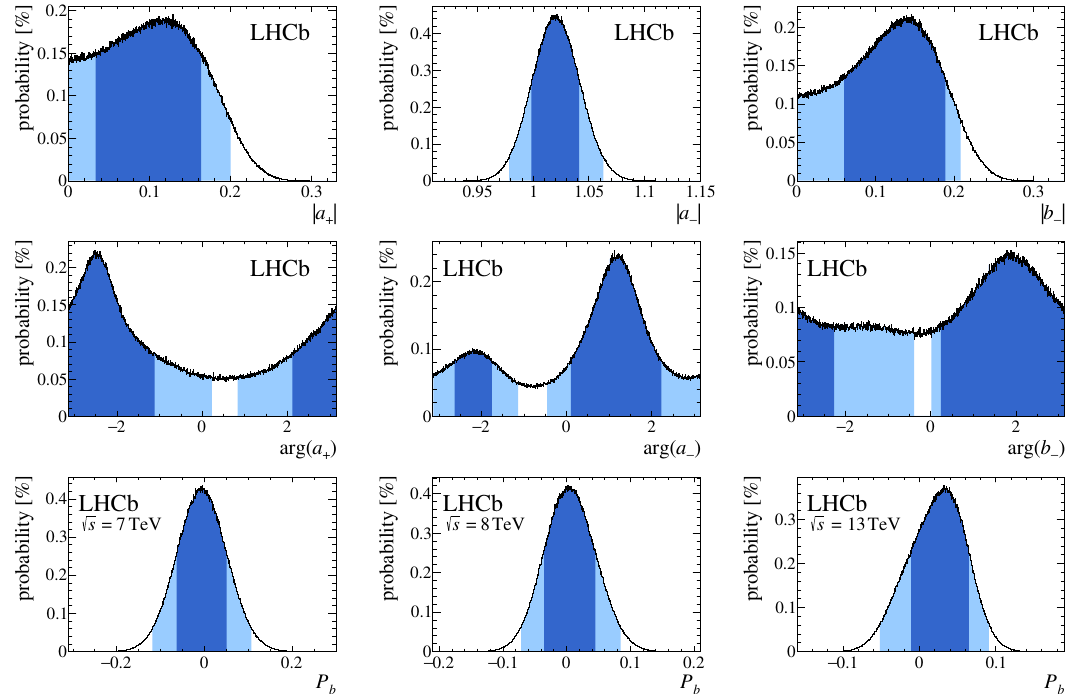
Figure 4 . Posterior probability distributions of j a (cid:6) j , arg( a (cid:6) ), j b (cid:0) j , arg( b (cid:0) ) and the transverse production polarisation of the (cid:3) 0 baryons, P b , at centre-of-mass energies of 7, 8 and 13 TeV assuming b uniform priors. The shaded regions indicate the 68% and 95% credibility intervals.